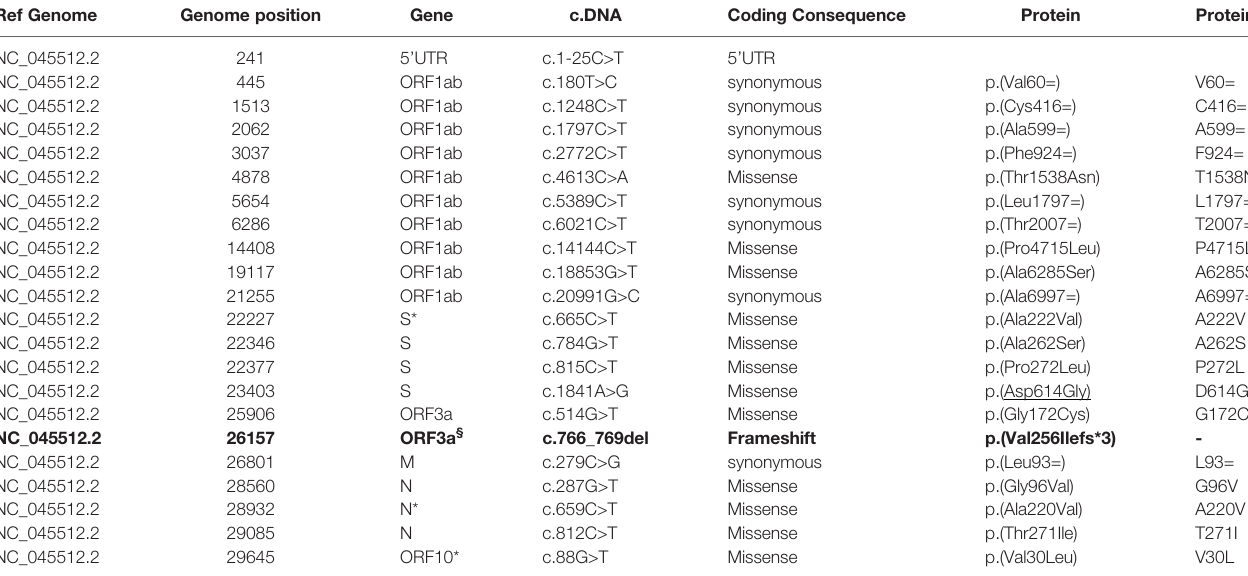
TABLE 1 | List of the 22 mutations identi fi ed in the patient ’ s